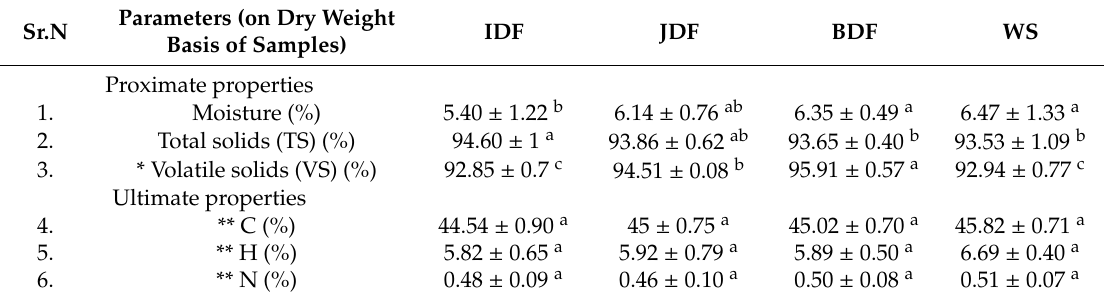
Table 3. Proximate and ultimate properties of basic raw material (% wt. as